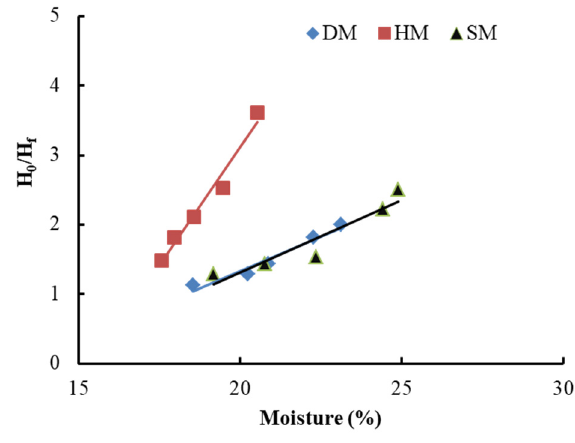
Figure 6. Typical chart of Pfefferkorn for DM, HM, and SM clays.